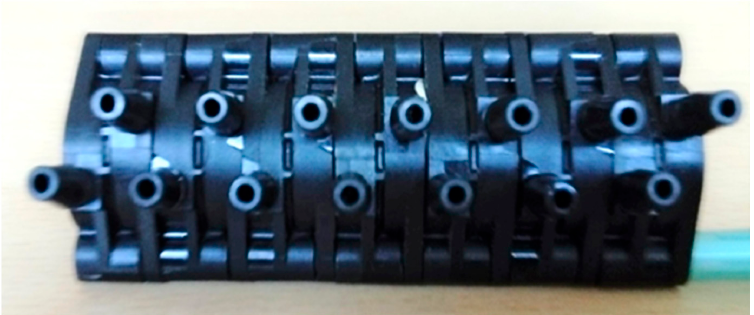
Figure 10. Scheme of installing and connecting the measuring and compensation sensors ( b ), C1—measuring sensor, C2—compensation sensor, K1 and K2—pressure input to the measuring sensor, K3, and K4—measuring inputs of the compensation sensor, out1—measuring sensor output, out2—compensation sensor output, ( b ) practical realization of scheme ( a ).